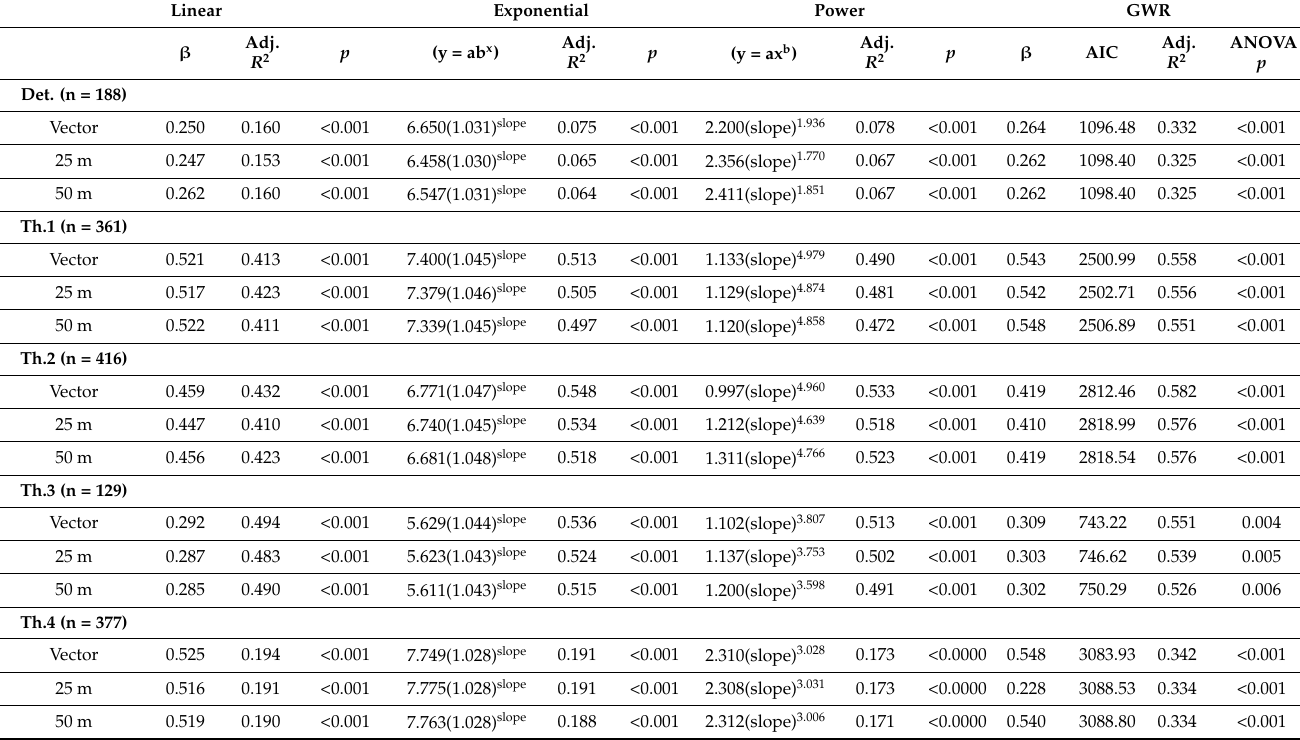
Table 1. Linear, semi-log (exponential), log-log (power), and geographically weighted regression model diagnostics for directional slope. Separated by fire and ATIR sequence. Det. = Detwiler Fire, Th. = Thomas